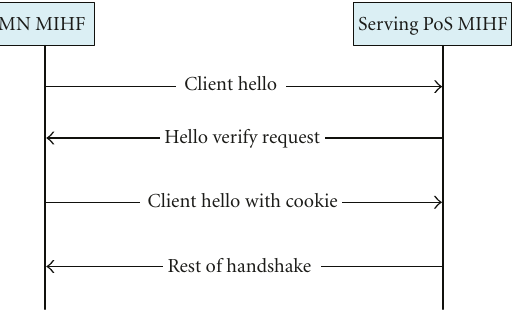
Figure 6: DTLS client server message exchange.